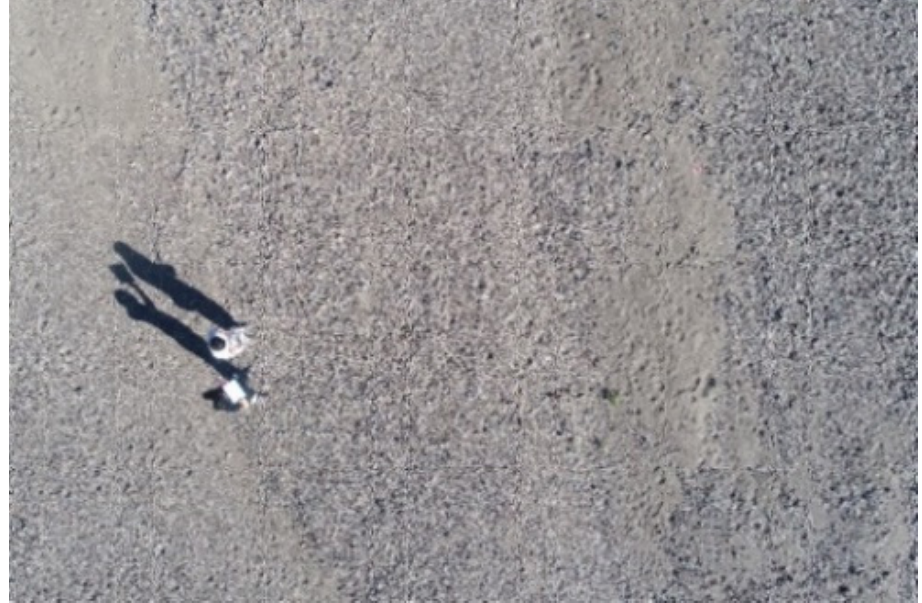
Figure 2. Images taken from UAV (10 m).